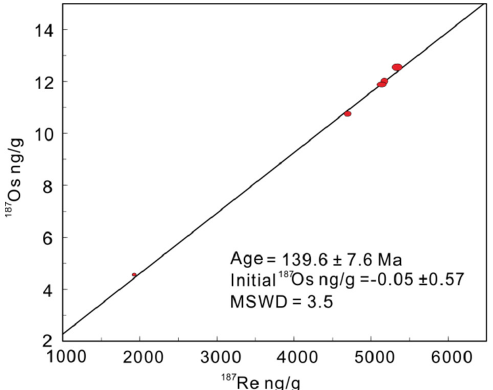
Figure 7. Re-Os isochron plot for molybdenite samples from the Baiyinhan tungsten deposit.